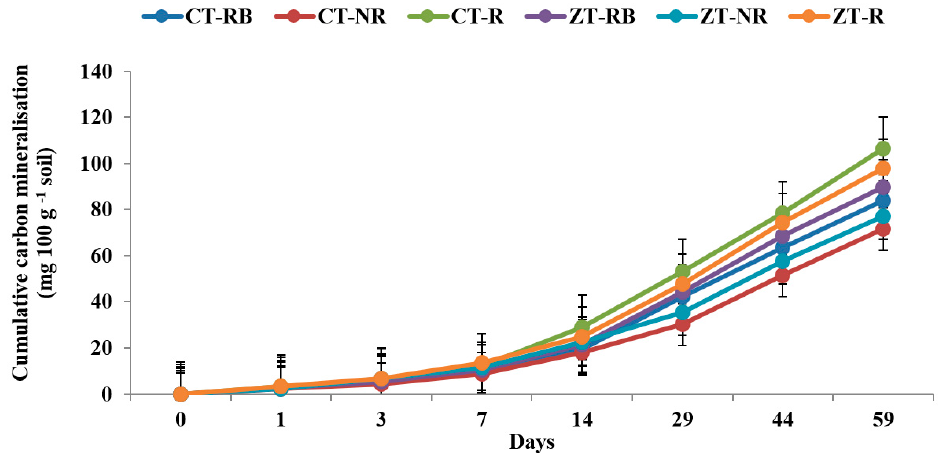
Figure 2. Cumulative carbon mineralization (mg 100 g − 1 soil) of bulk soil in 0–5 cm depths as affected by 18 years of tillage and residue management in a rice–wheat cropping system in an Inceptisol at 27 ◦ C. ZT = zero tillage; CT = conventional tillage; NR = no residue; RB = residue burning; R = residue retention. Error bars identify LSD ( p ≤ 0.05) of different